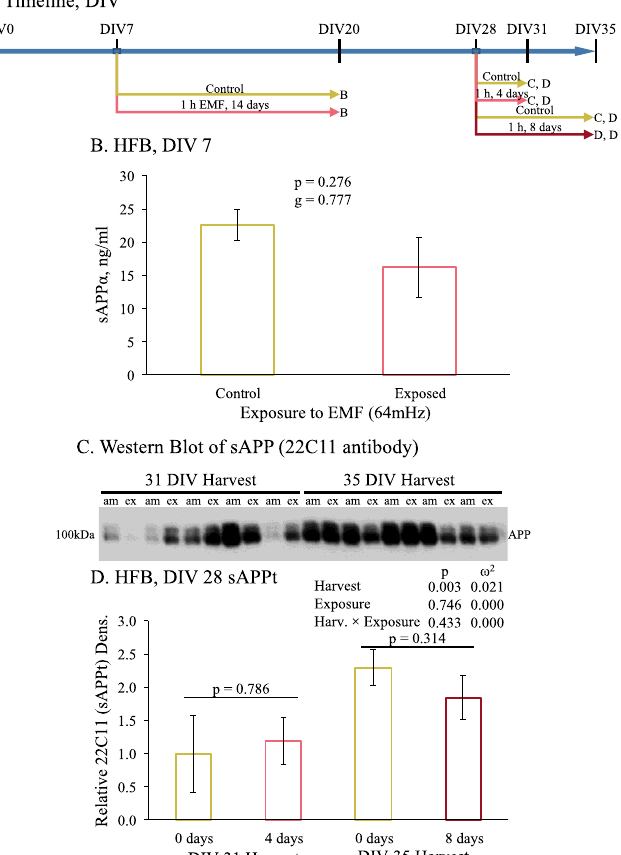
Figure 3. Effect of REMFS on levels of sAPPα and sAPP in human brain cultures at DIV7 and DIV28. Cultures were grown for 7 or 28 days and then exposed as described in the text for 14 (DIV7) or 4 or 8 days (DIV28), as described in the text. CM was assayed for levels of sAPP or sAPPα. sAPPα was measured by ELISA. Total sAPP was measured by semi-quantitative western blotting. ( A ) Schedule of cell growth and treatments for data presented in figure. ( B ) sAPPα was measured by ELISA of CM from PHB-DIV7 exposed to REMF for 14 day as described in the text. REMFS does not cause a significant change in levels of sAPPα. ( C ) Total sAPP was measured by semiquantitative western blotting of CM from PHB-DIV28 exposed to REMFS at 64 MHz with SAR of 0.9 W/kg for 4 or 8 days, as described in the text. ( D ) Analysis of blot densitometry revealed that, while the interval between 28 + 4 and 28 + 8 days significantly increased sAPP, there was no effect of REMFS